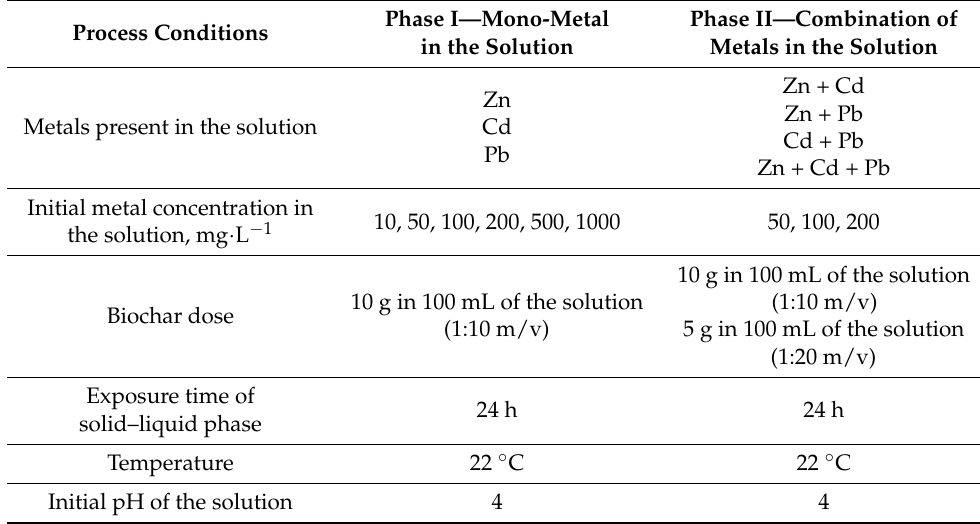
Table 2. Phases of batch sorption